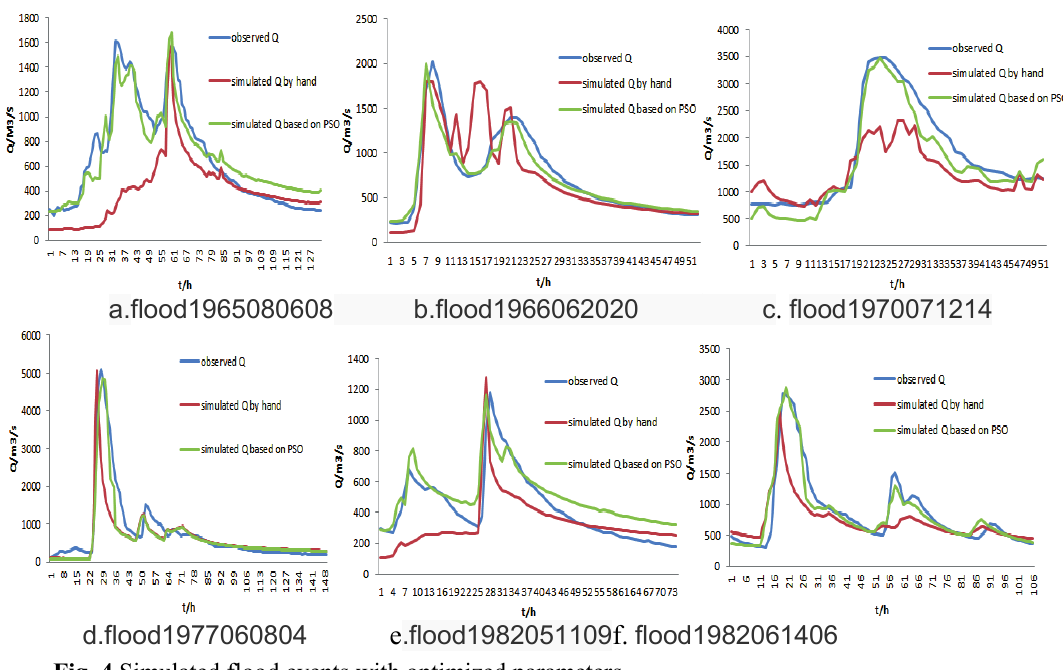
Fig. 4 Simulated flood events with optimized